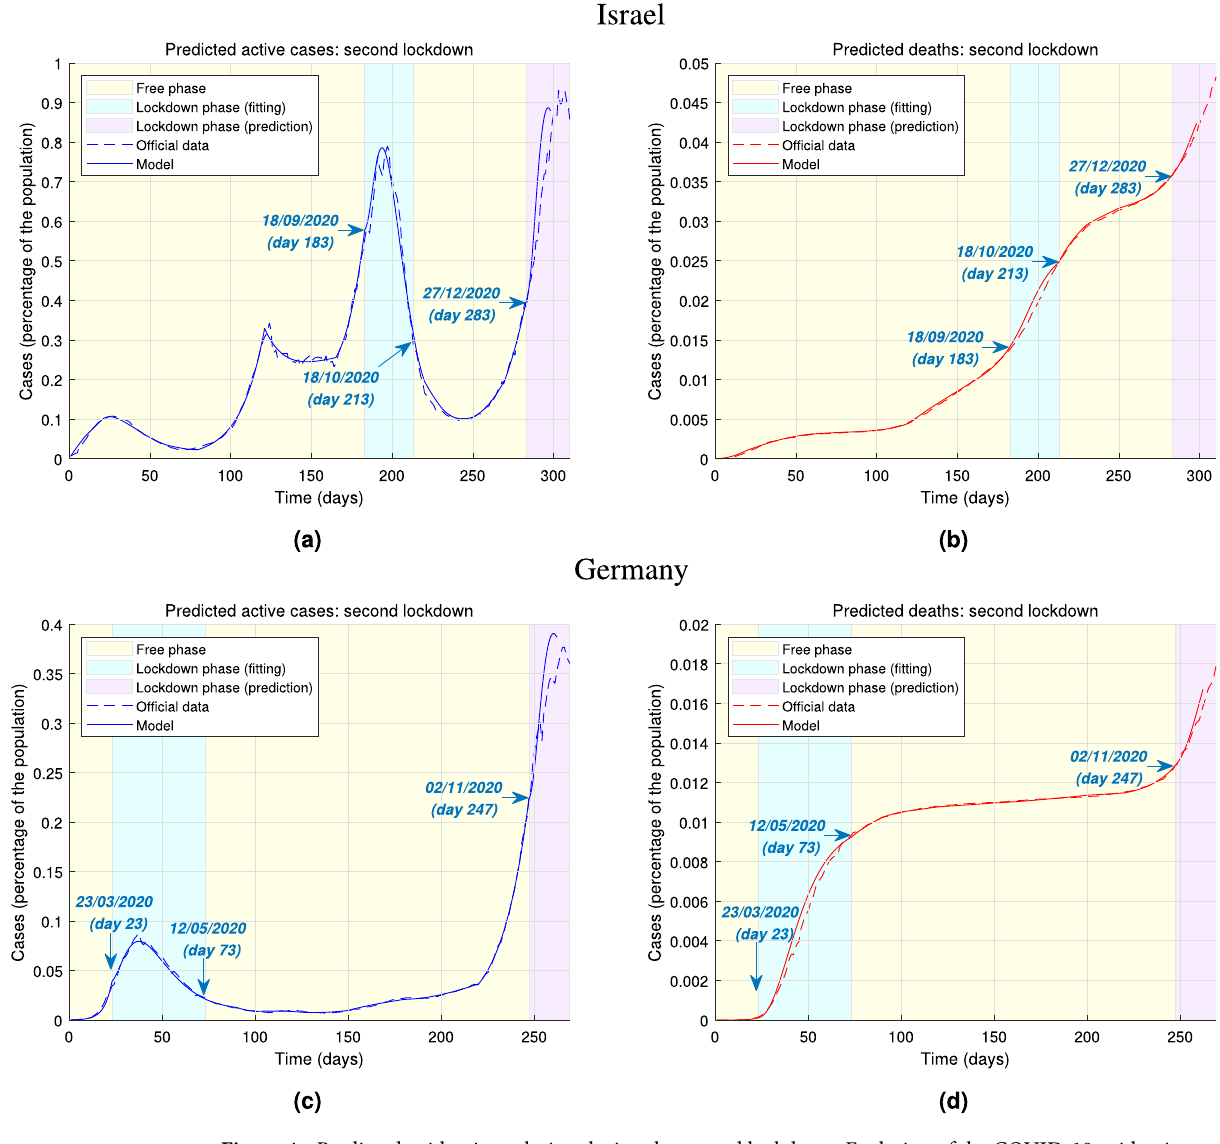
Figure 4. Predicted epidemic evolution during the second lockdown. Evolution of the COVID-19 epidemic in Israel and Germany during a second national lockdowns as predicted by our model, based on available government data. The prediction of the evolution during the second lockdown (enforced at the start of the second “wave”) is performed assuming no data from the future course of the epidemic is available at the start of the lockdown. ( a ) Actual evolution and model prediction of the active cases of infections in Israel throughout the epidemic. ( b ) Actual evolution and model predictions of the deaths in Israel throughout the epidemic. ( c ) Actual evolution and model predictions of the active cases of infections in Germany throughout the epidemic. ( d ) Actual evolution and model predictions of the deaths in Germany throughout the